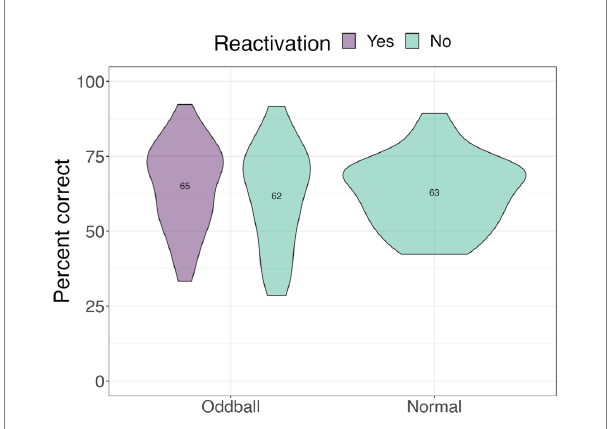
FIGURE 10 Mean accuracy for the visual recognition task in Experiment 2.